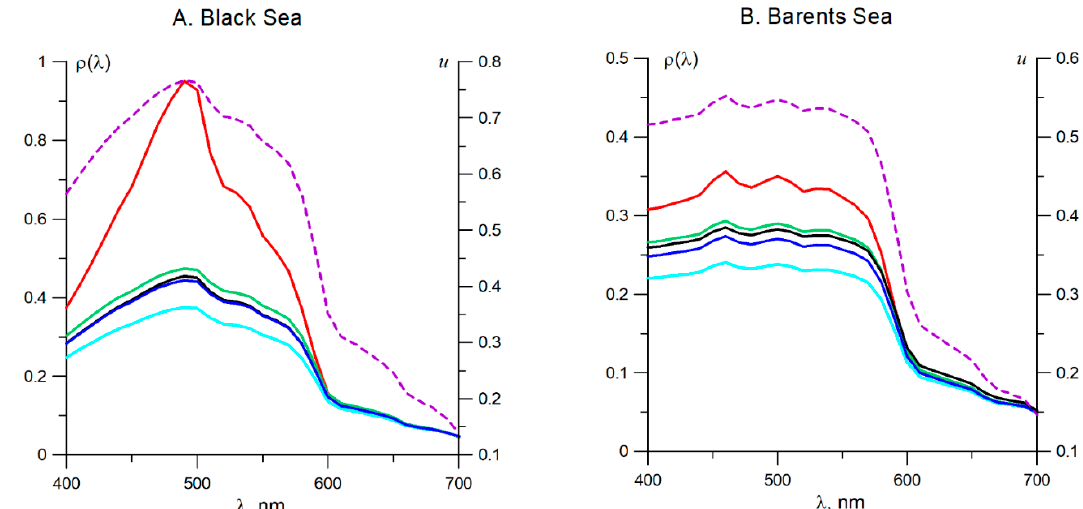
Figure 15. Spectral values of ρ ( λ ) obtained for N coc = 10 7 cell / L by numerical simulation (black curves) and by using approximate formulas (the color of the curves corresponds to Figure 13), in comparison with parameter u (dashed purple lines and right axis). ( A ) Black Sea, a (440) = 0.09 m − 1 , θ 0 = 25°; ( B ) Barents Sea, a (440) = 0.18 m − 1 , θ 0 = 60°. Table 7. Absolute and relative errors of Equations (7–10), depending on the N coc value and the solar zenith angle for the Black Sea, λ = 490 nm and a (440) = 0.09 m − 1 . The value of parameter u is shown in the first column in brackets.